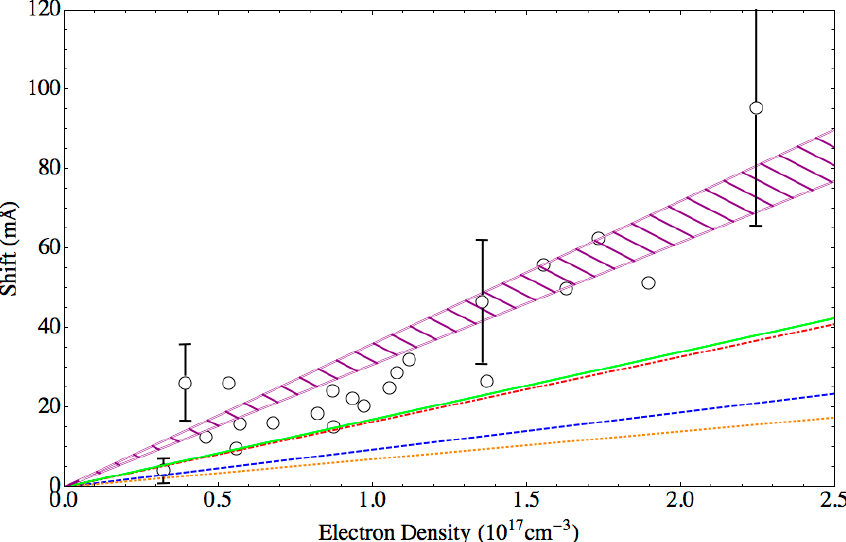
Figure 4. Comparison of the experimental shift of the He II Balmer-alpha line 1640 A measured by Pittman and Fleurier [40], shown by circles, with the following theoretical shifts: Griem’s shift [41,43]—dashed blue line; plasma polarization shift-dotted orange line; the sum of the latter two theoretical shifts-dashed-dotted red line; shift due to penetrating ions [39]—solid green line; the sum of all three theoretical shifts-purple band, the width of which reflects the theoretical error. The experimental error bars are shown only for few electron densities in order to avoid making the figure too “busy” and difficult to understand.